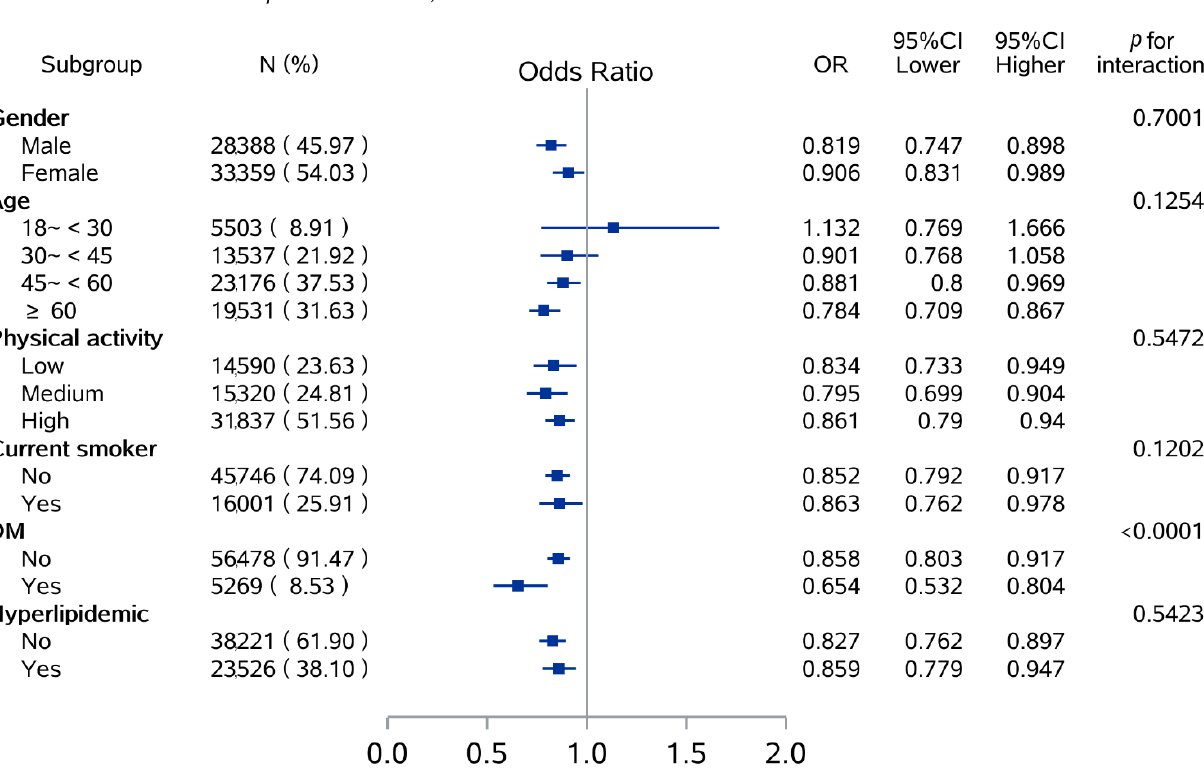
Figure 3. Subgroup analysis of odds ratio (Q5 vs. Q1) between BBP-diet score and risk of HTN according to potential risk factors. Table 3. Association between dietary pattern scores and well-controlled hypertension in the